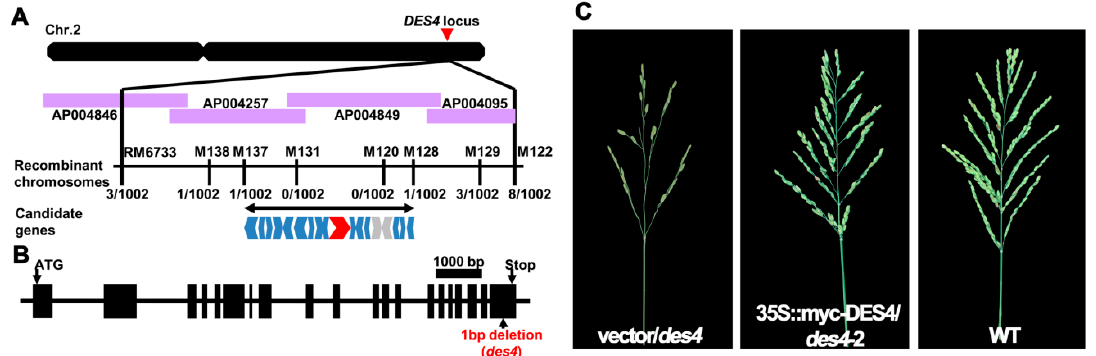
Figure 2. Genetic mapping and complementation analysis of DES4 . ( A ) Map-based cloning of DES4 . The markers for PCR-based mapping are listed in Table S1. “Recombinant” indicates recombination between maker and phenotype; the numbers indicate the numbers of recombinant lines out of 1002 mutant type lines analyzed. Red shape indicates Os02g0782800 candidate gene; blue shapes indicate the 16 sequenced candidate genes; and grey shape indicates the transposon genes. ( B ) Schematic presentation of the gene structure of DES4 . Boxes represent the exons and the line indicates the intron. One base pair deletion occurred on the last exon of DES4 . The mutated sequence is presented in Data S1. ( C ) Panicle architectures of negative control (empty vector) line, genetically complemented line, and WT.